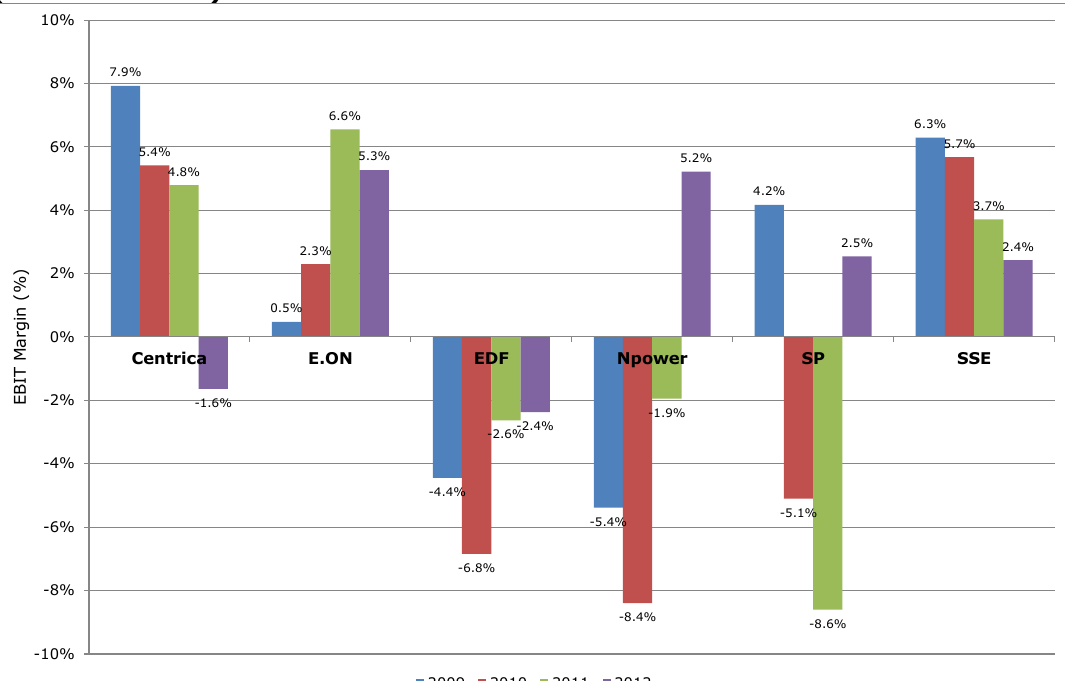
Figure 48: Six largest suppliers’ Domestic Electricity Supply EBIT Margins (% of revenues)